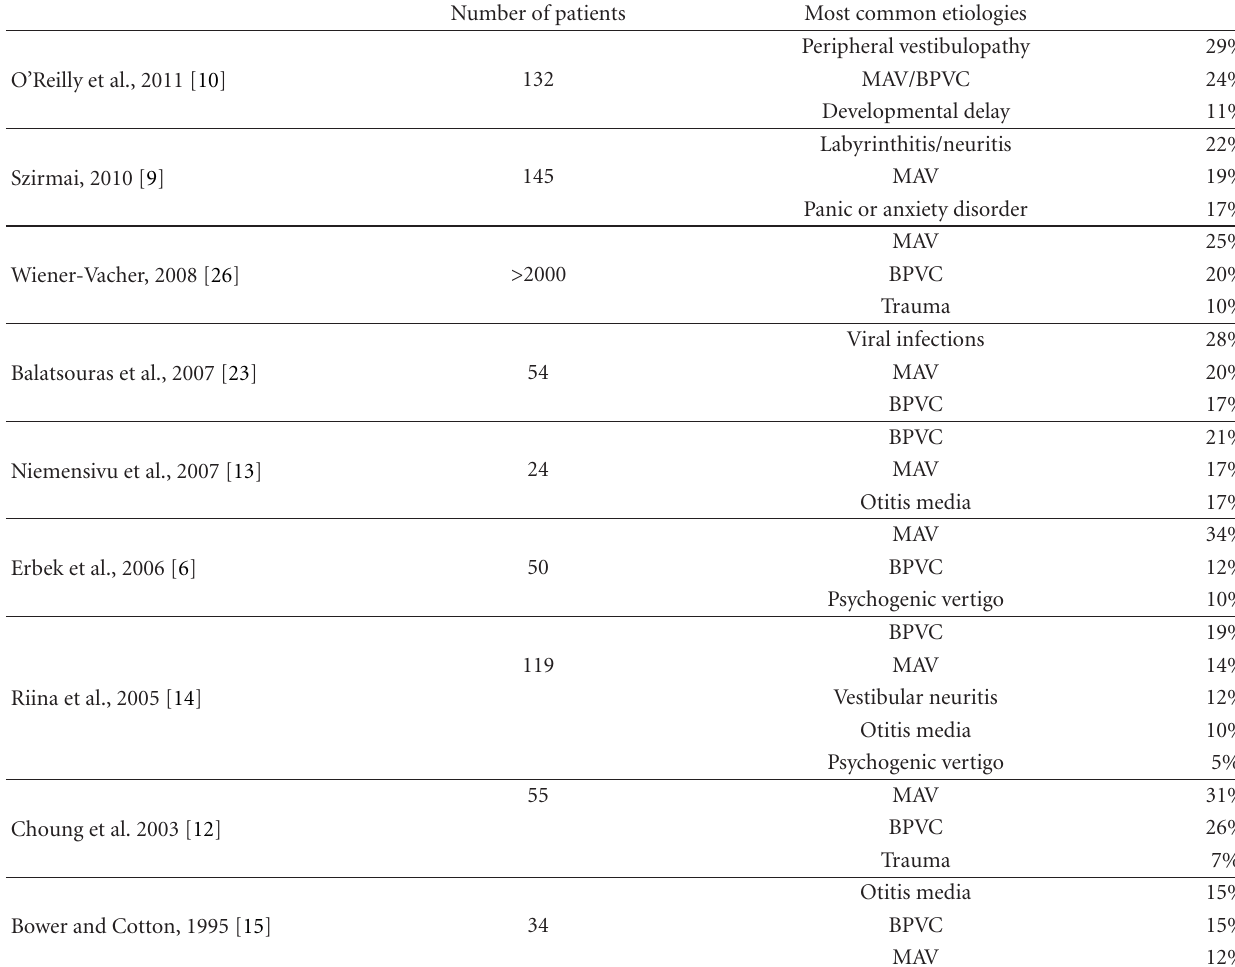
Table 3: Previous studies on dizziness and vertigo in children and